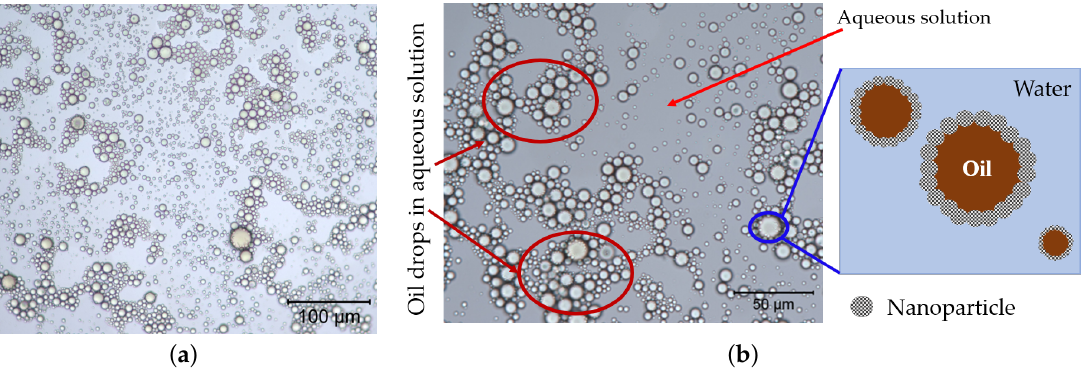
Figure 8. Visualisation of oil-in-water emulsion droplets from core flood effluent: ( a ) 20 × magnification image, and ( b ) 50 × magnification